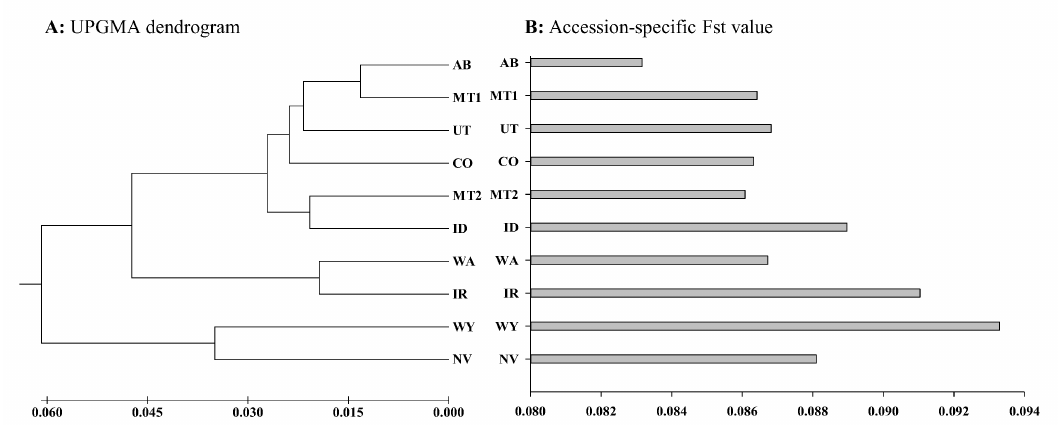
Figure 5. Genetic diversity and genetic relationships of the 10 northern wheatgrass accessions. The left panel ( A ) displays their genetic relationships in a UPGMA dendrogram based on the Phi statistics obtained from the AMOVA. The right panel ( B ) shows the accession-specific Fst values for the 10 accessions. The accession labels are given in Table